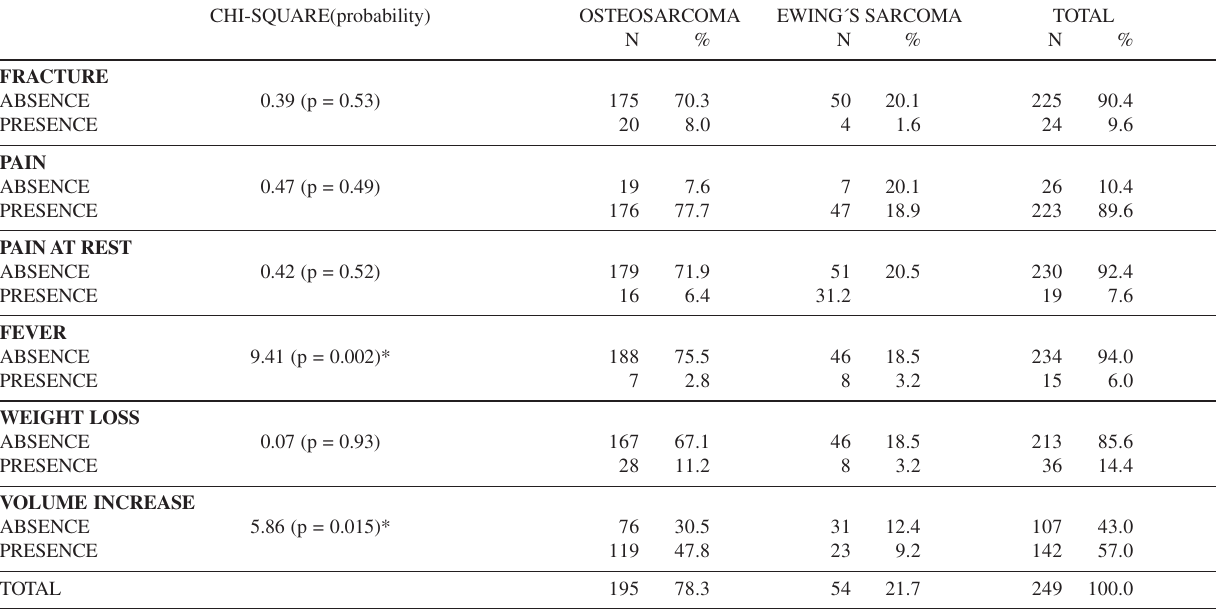
Table 4 - Absolute and relative frequency distribution (%) of fracture, pain, pain at rest, fever, weight loss and local volume increase as early symptoms of patients in the Osteosarcoma and Ewing’s Sarcoma groups, and intergroup comparison using a two-tailed chi-square test (±=0.05)